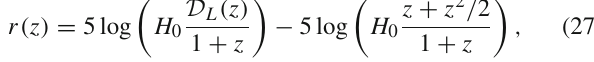
by adding the effects of the uncertainties. 9 We see that the uncertainties from τ c , z g 0 , R g and ξ